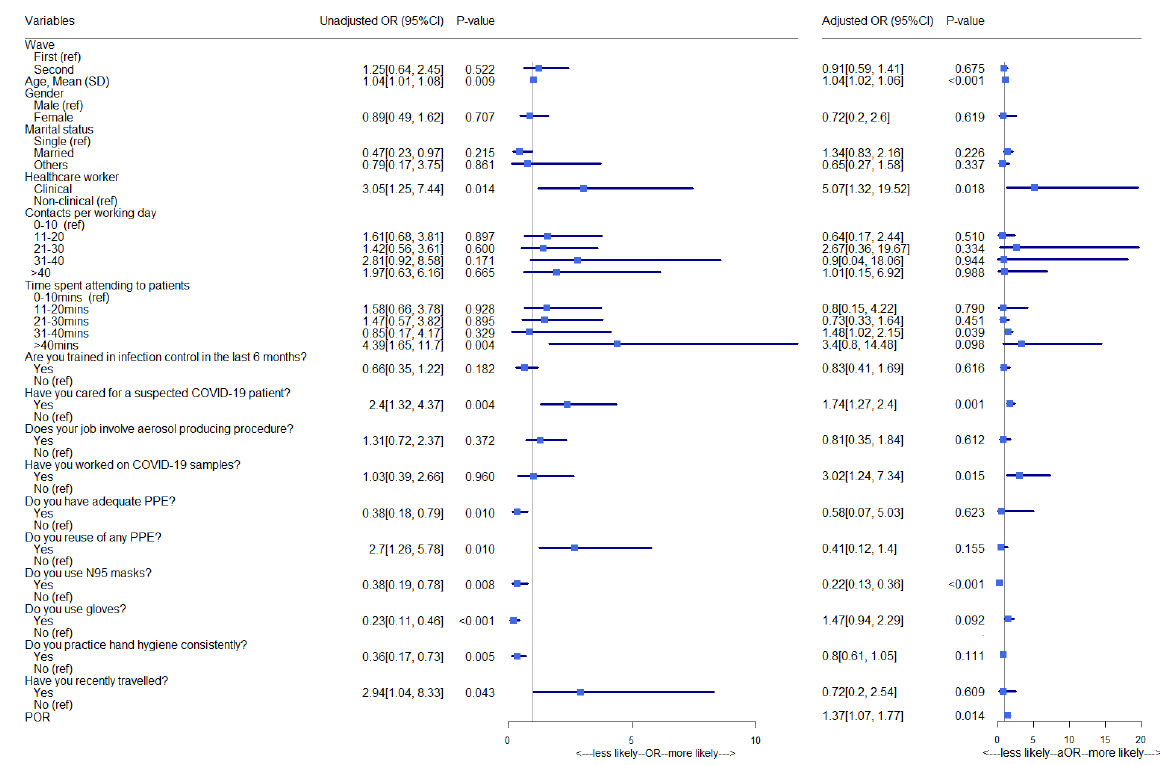
Figure 2. Association (univariable and multivariable) between COVID-19 infection and HCWs baseline characteristics and risk of exposure.